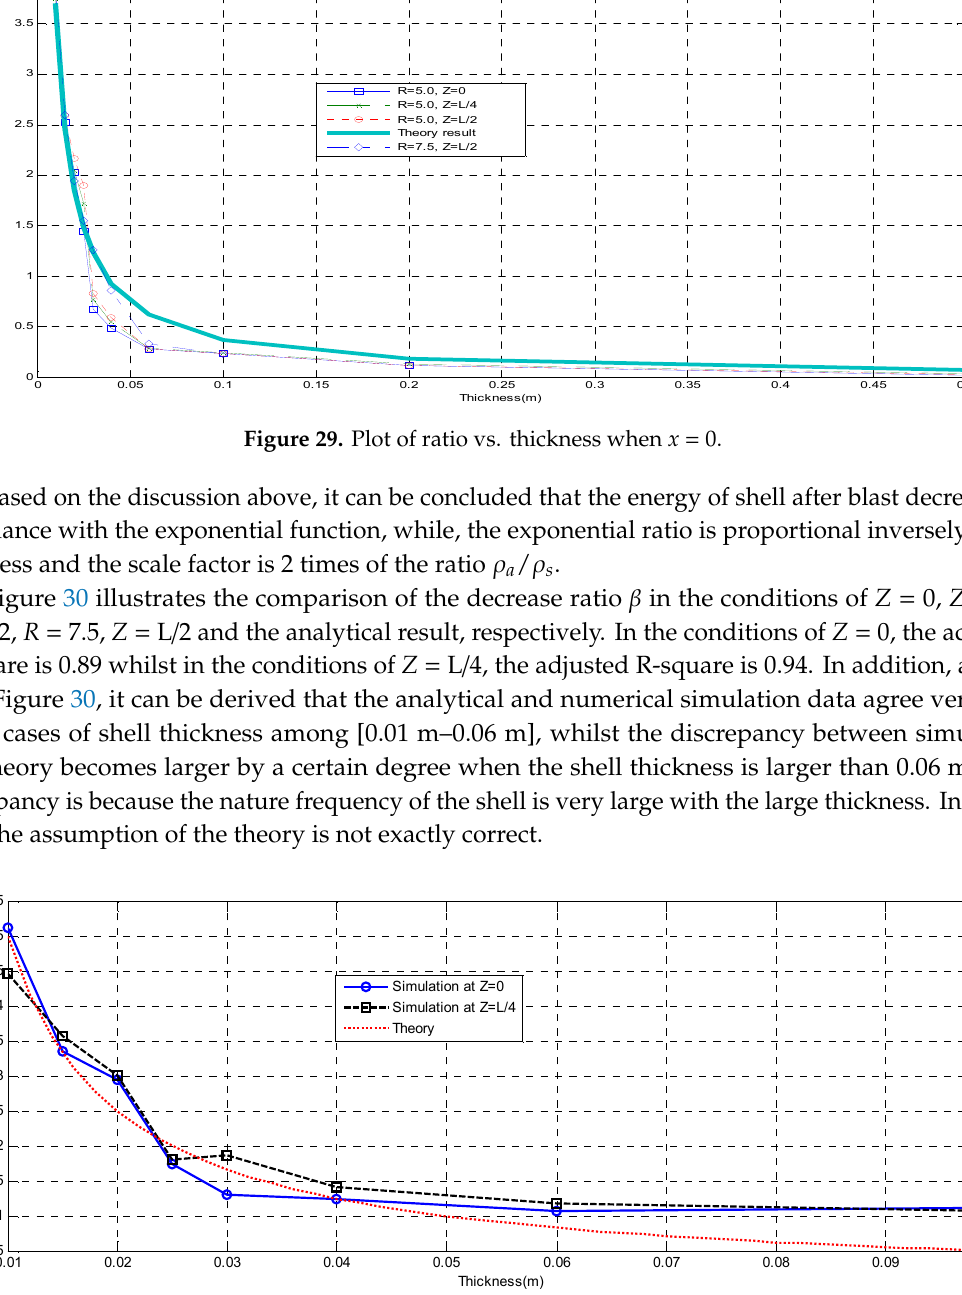
Figure 30. The comparison of decreasing ratio in the conditions of Z = 0, Z = L /4 and theory.